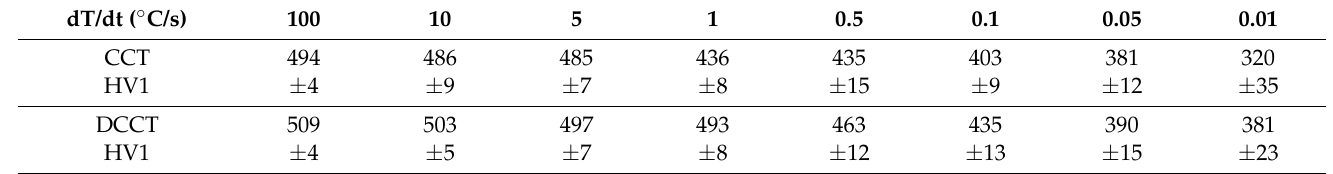
Table 6. Dependence of hardness HV1 on cooling rate in CCT and DCCT